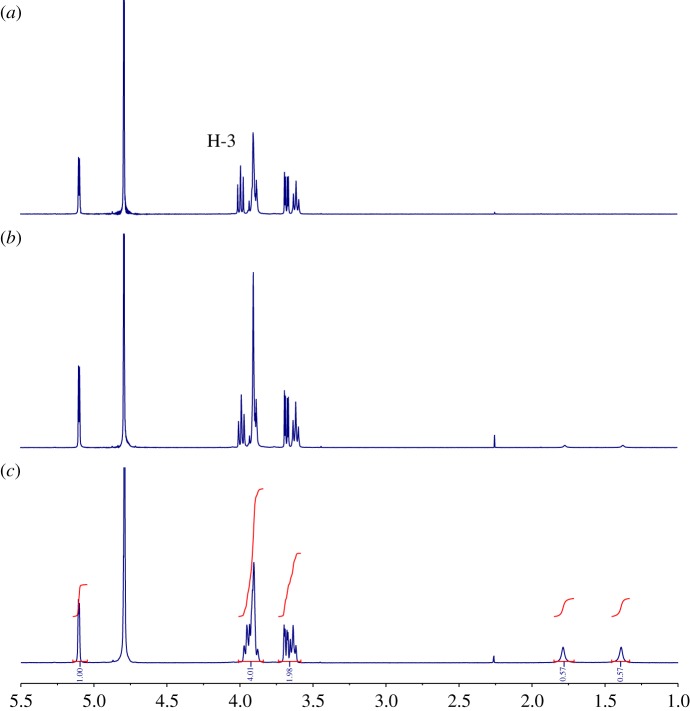
1H-NMR spectra (D2O, 500 MHz) of (a) β-CD; (b) β-CD + DADP and (c) β-CD + DADP sonicated for 2 min.